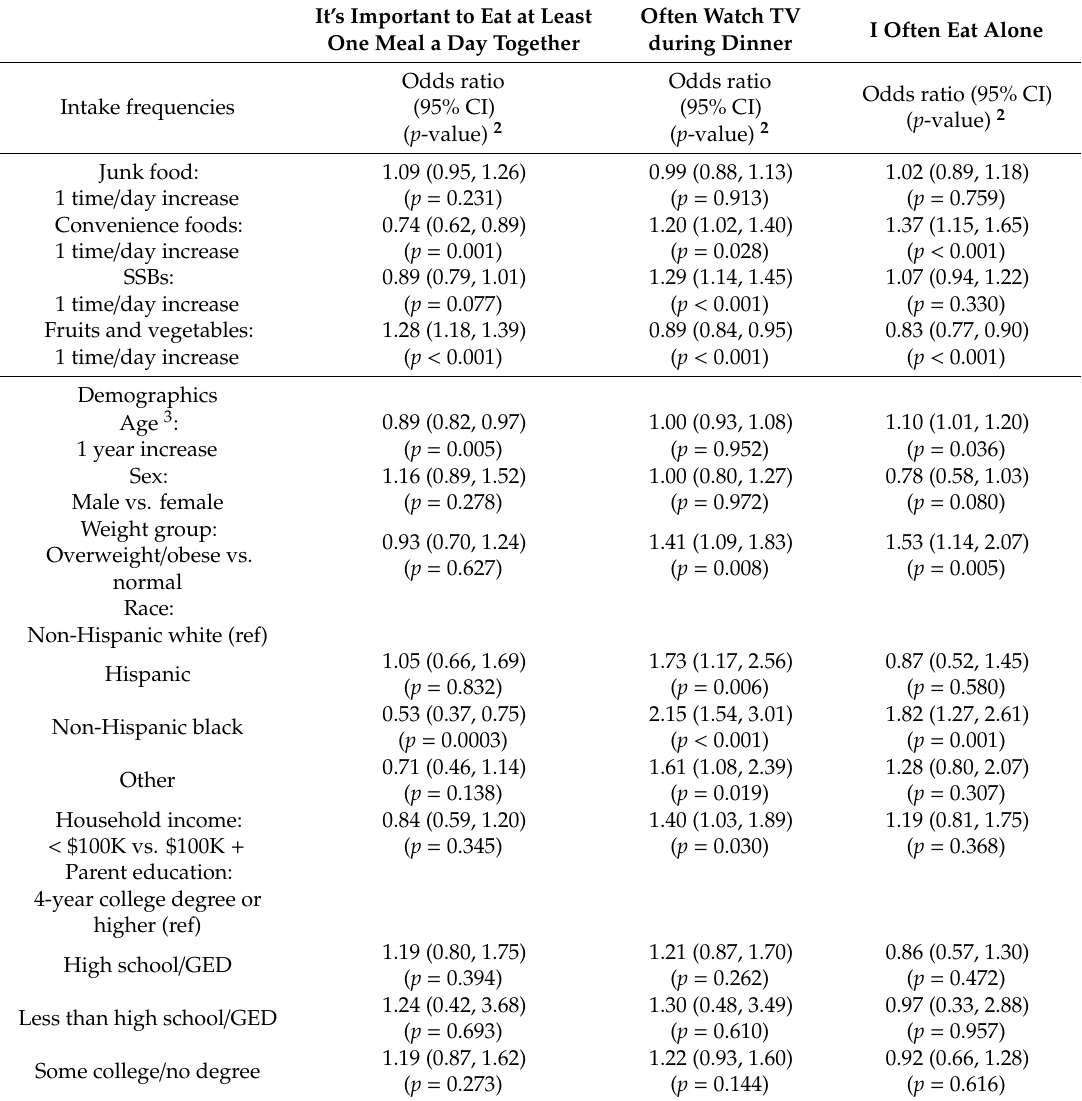
Table 3. Odds ratios 1 of agreement with family meal characteristics and daily intake frequencies of adolescent foods of interest and